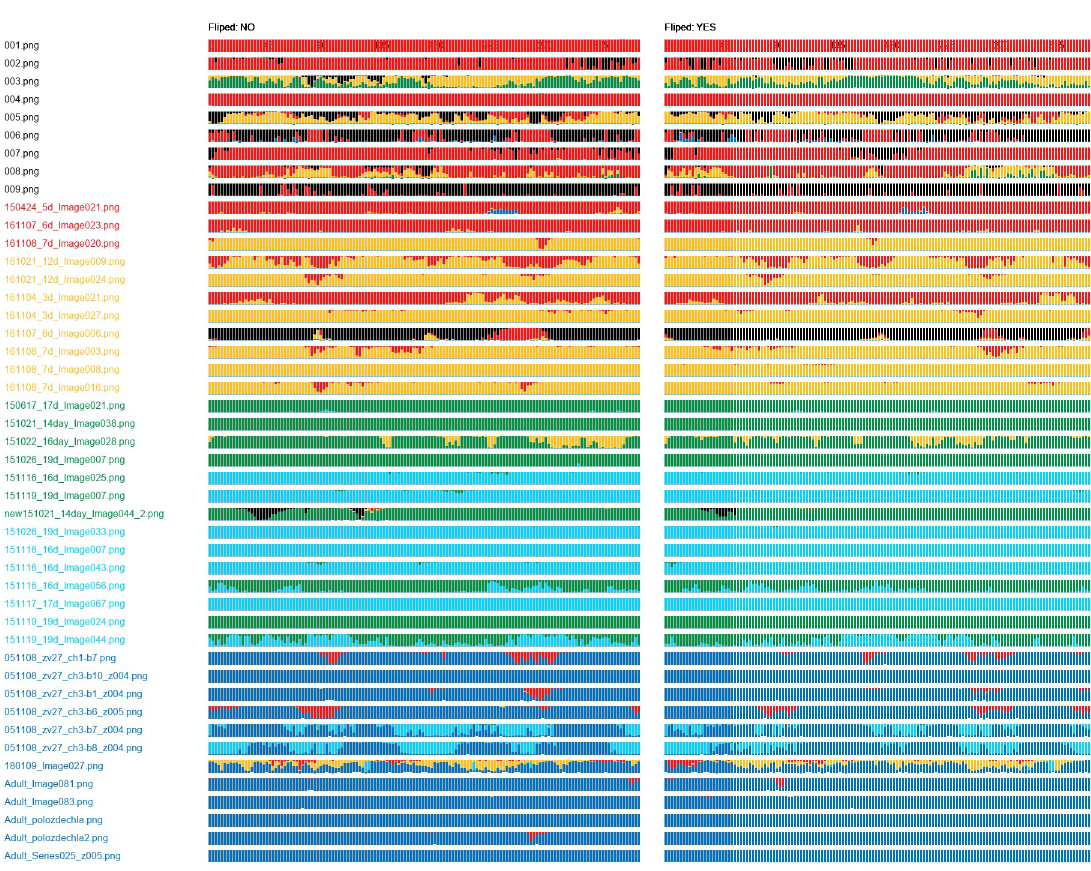
Fig 9. Class probability graph obtained for the DenseNet-1024 trained on T-1024-A. Except the class 0, the network correctly recognizes more than 50% of samples in each class; however, the 50% border line is exceeded only slightly for most of the classes. The only exception is the class 5 where almost all samples are correctly